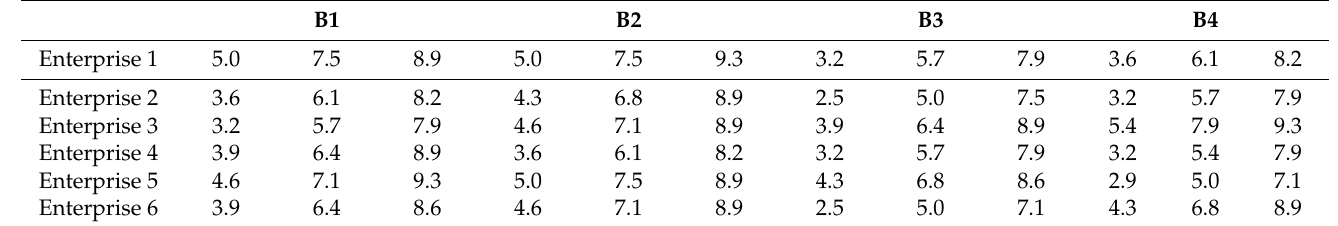
Table 5. Fuzzy mean values of the secondary indicators of energy conservation and carbon reduction (B) of the six evaluated